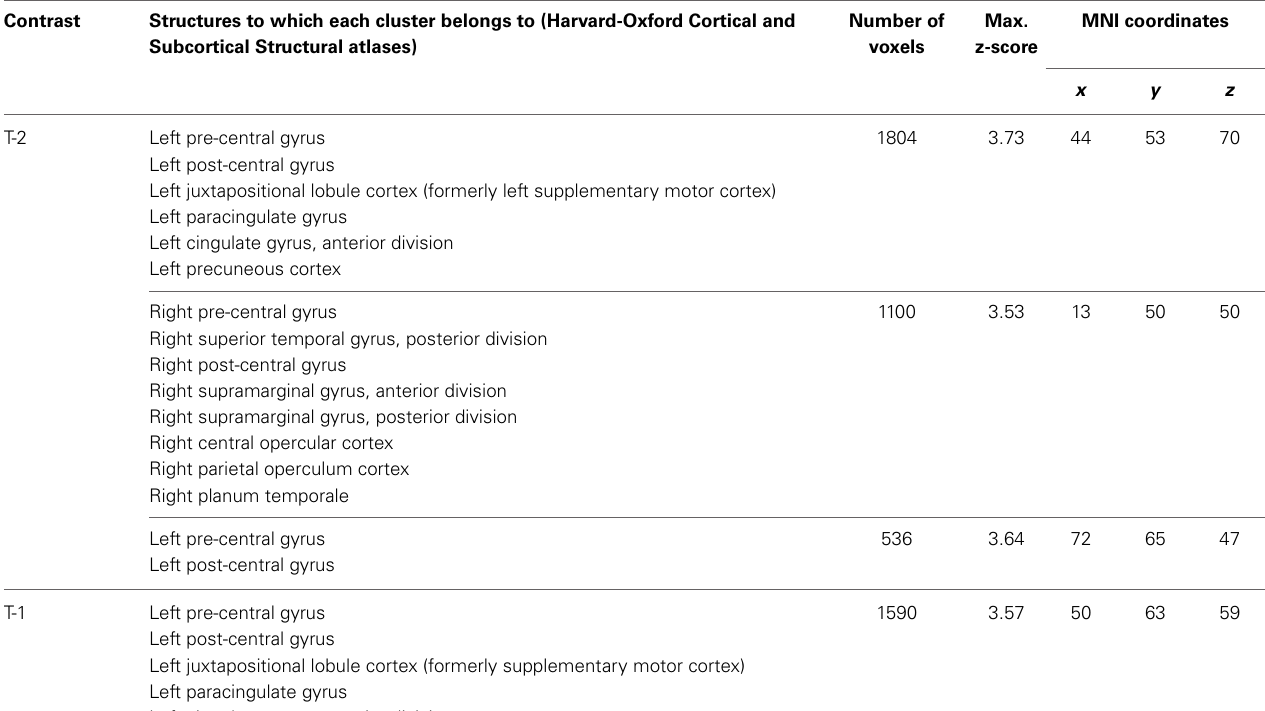
Number of Max. MNI voxels z-score